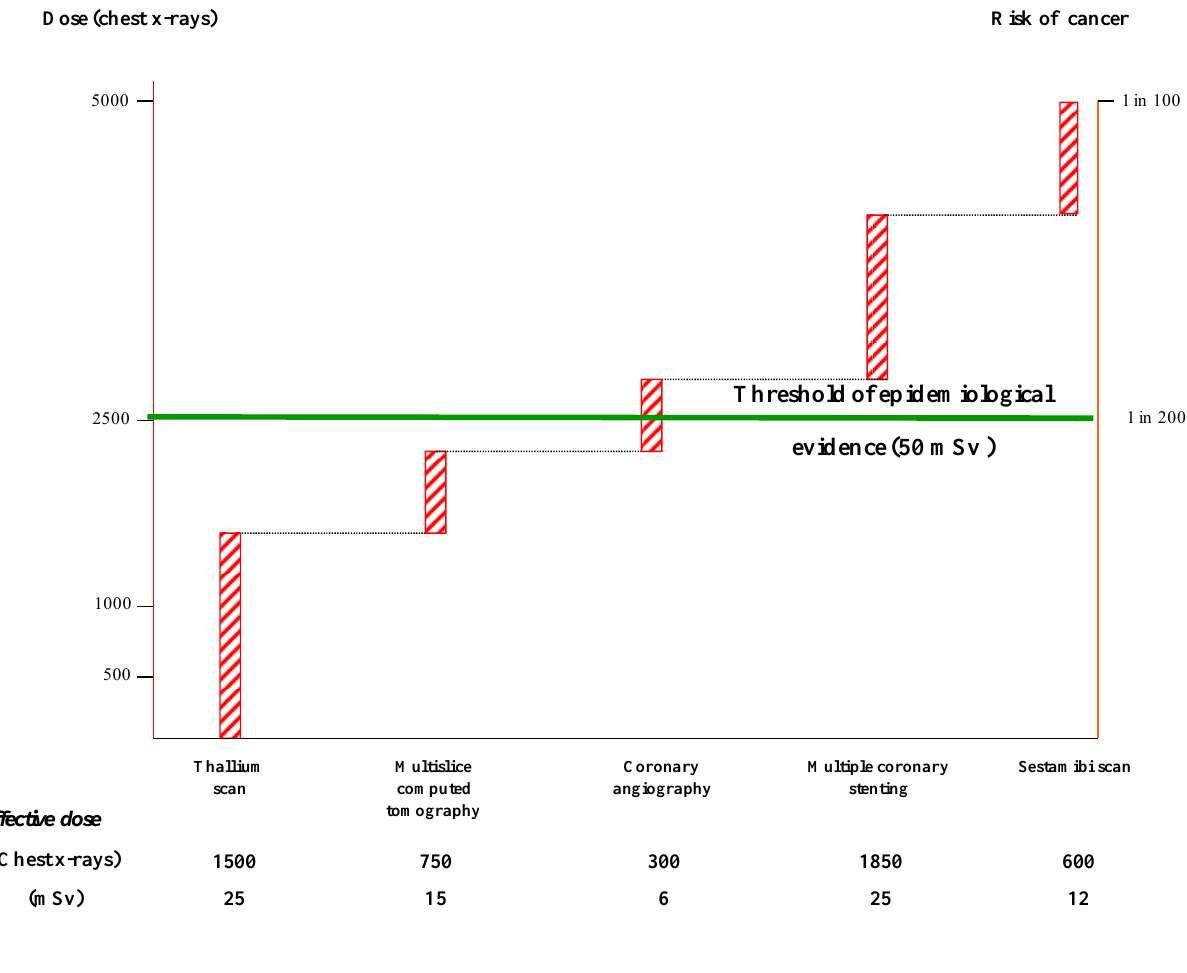
Risk of cancerDose (chest